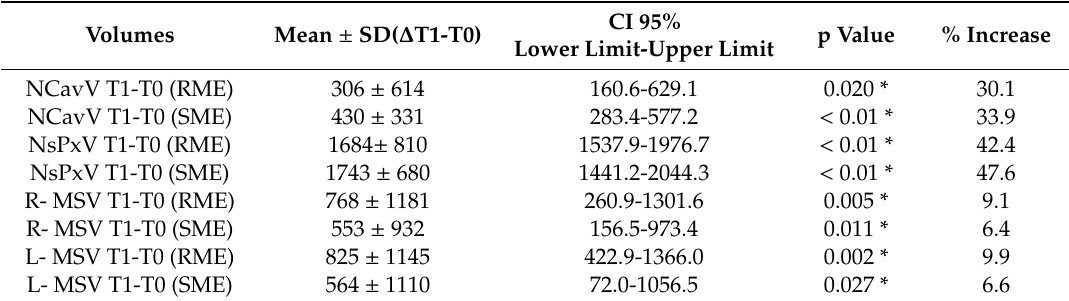
Table 3. Descriptive statistics (mean ± standard deviation), confidence interval, and paired t -test comparing upper airway volumes before (T1) and after (T2) in both groups.